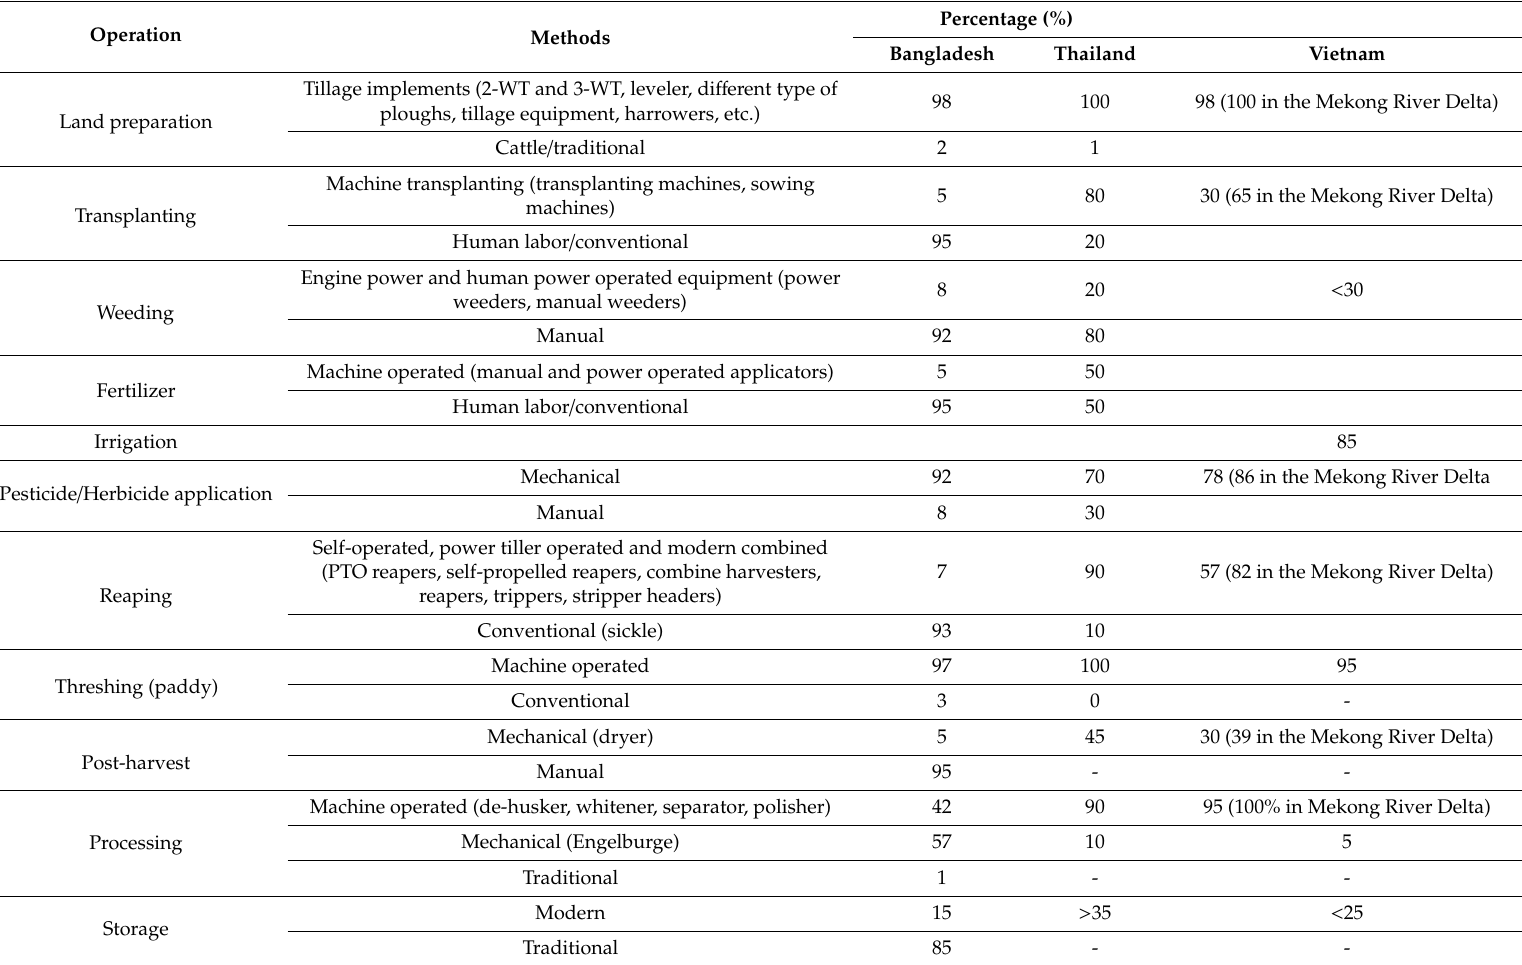
Table 2. Status of farming activities modernization in Bangladesh, Thailand and Vietnam in percentages